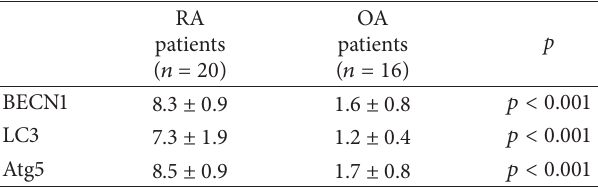
Figure 1: The relative expression levels of beclin1, Atg5, and LC3 mRNA in synovial tissue. The levels of beclin1, Atg5, and LC3 mRNA expression in synovial tissue from RA ( 𝑛 = 20 ) and OA ( 𝑛 = 16 ) patients. ∗∗ 𝑝 < 0.01 ; the error bars indicate standard deviation. Table 3: The immunohistochemical reaction score of RA and OA patients (mean ±